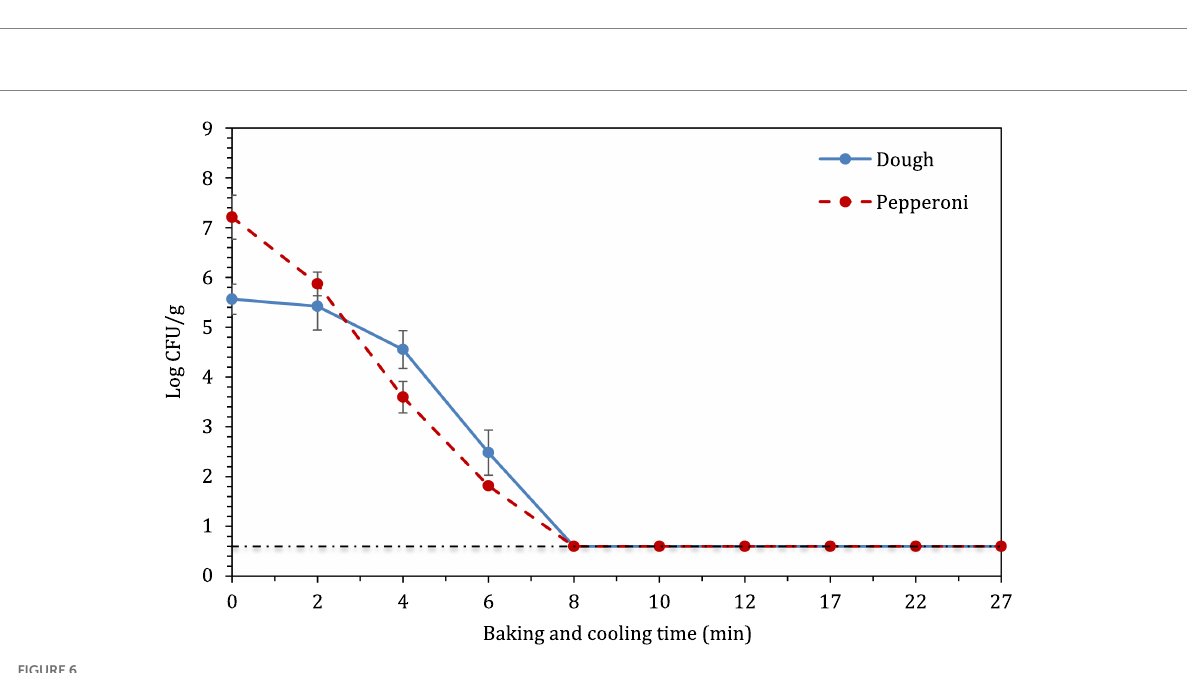
FIGURE 5 pH of pizza samples during 12 min of baking followed by 15 min of ambient cooling.